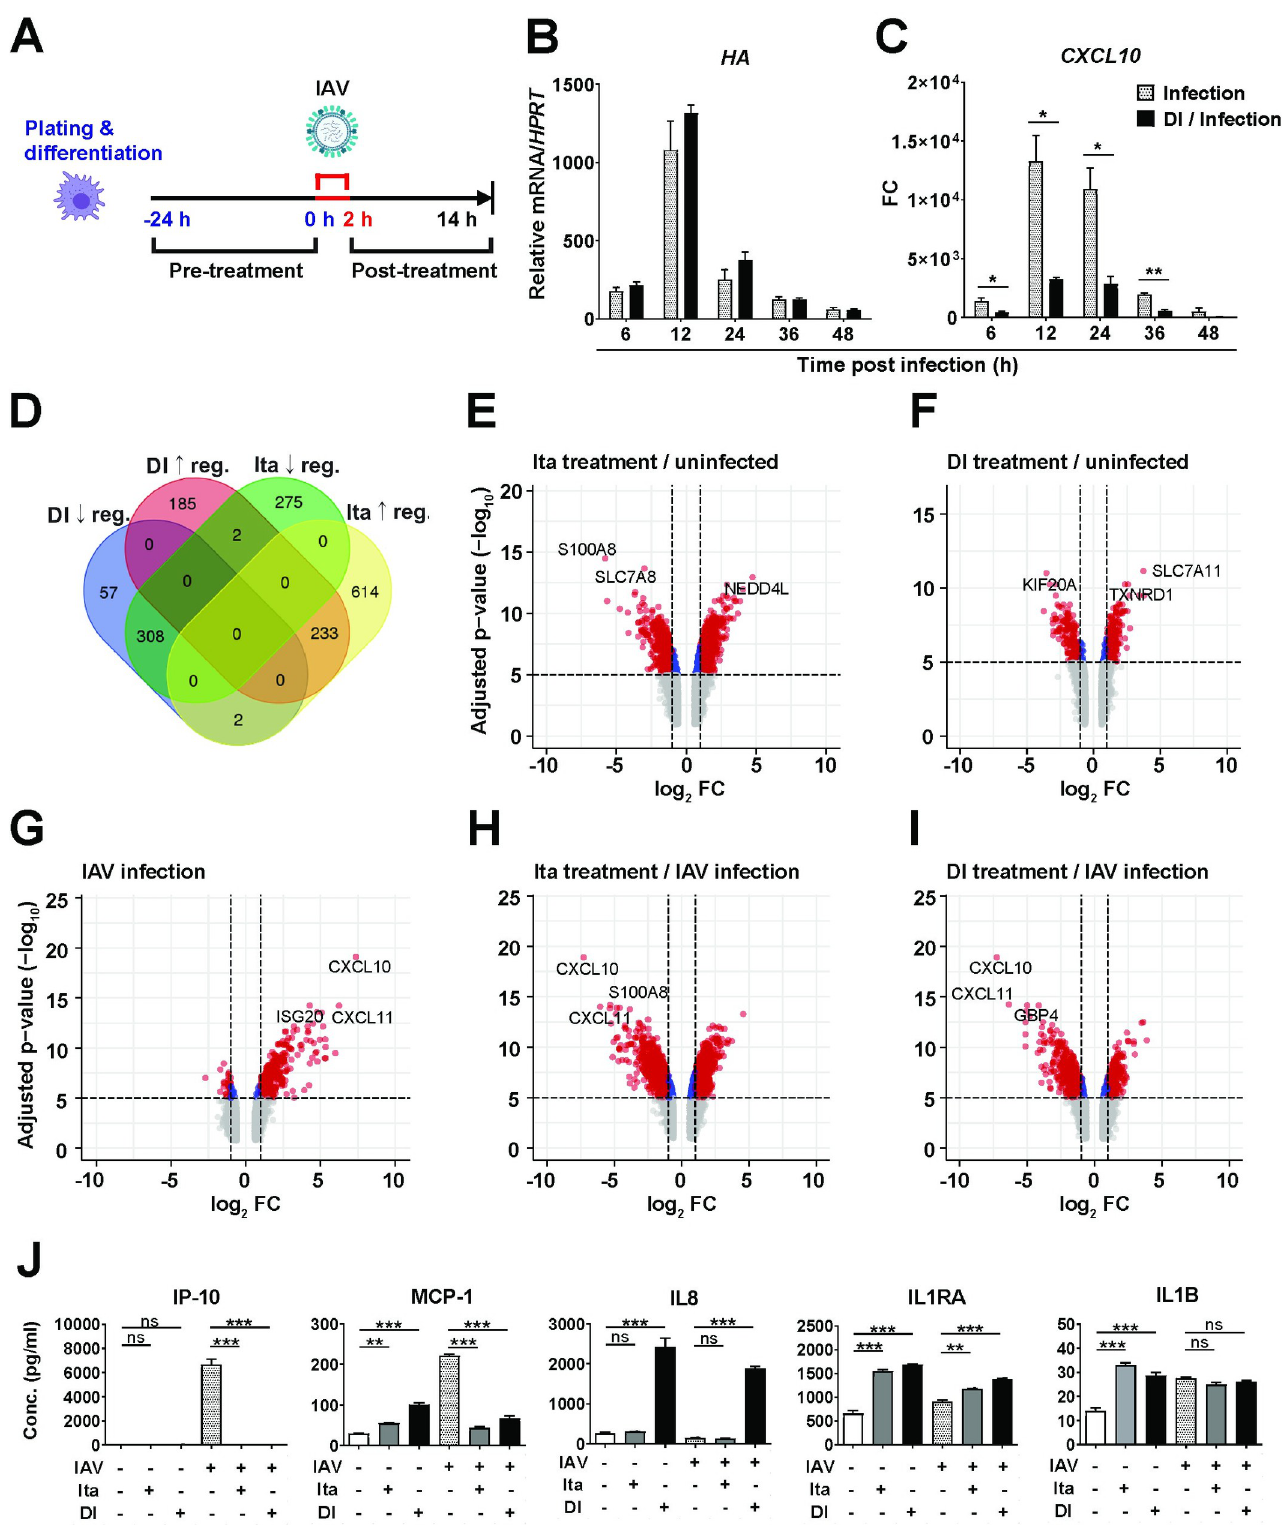
Fig 3. Effects of itaconate and DI on cellular inflammation due to IAV infection of dTHP-1 cells. A. Outline of experiment. dTHP-1 cells were treated with itaconate or DI overnight, or left untreated, and then infected with IAV (PR8M, MOI = 1). Dose-response curves of effects of a range of itaconate and